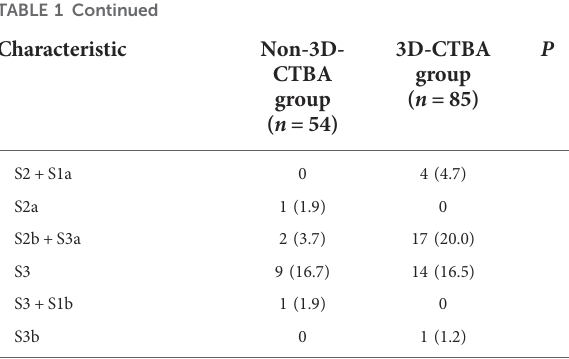
COPD, chronic obstructive pulmonary disease; 3D-CTBA, three-dimensional computed tomography bronchography and angiography; IQR, interquartile range.